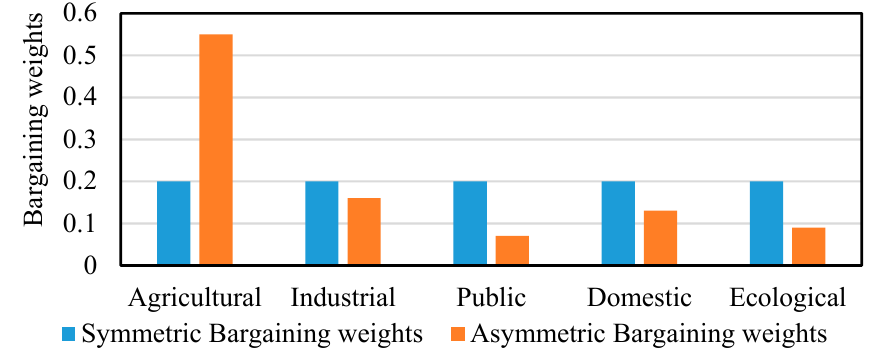
Figure 13. Bargaining weights of five water use sectors.